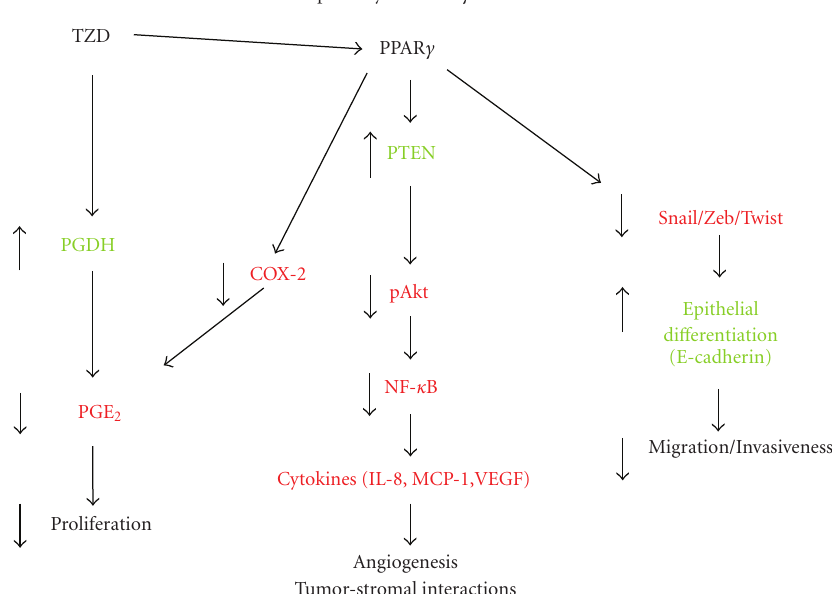
Figure 2: E ff ector pathways for PPAR γ in NSCLC . PPAR γ can increase either expression of enzymatic activity of PTEN. This results in inhibition of Akt activation (pAkt), which may be involved in the growth inhibitory responses seen with PPAR γ activation. Decreased Akt activity also can lead to decreased activity of the transcription factor NF- κ B. NF- κ B is a critical transcription factor in the production of proangiogenic and proinflammatory cytokines such as VEGF, IL-8. Decreased production of these factors would be expected to inhibit recruitment of inflammatory cells such as macrophages, and block tumor angiogenesis. PPAR γ -mediated suppression of members of the Snail family of transcription factors, such as Snail, Zeb, or Twist, would lead to derepression of E-cadherin expression and promote the epithelial phenotype, leading to decreased migration and invasiveness. PPAR γ -mediated suppression of COX-2 expression in NSCLC has been shown by several investigators. This would result in decreased PGE 2 production, which will impact growth. TZDs can inhibit PGE 2 production through a PPAR γ -independent pathway involving induction of 15-hydroxyprostaglandin dehydrogenase (PGDH). Pathways indicated in green are increased or activated by PPAR, while those in red represent pathways that are inhibited or